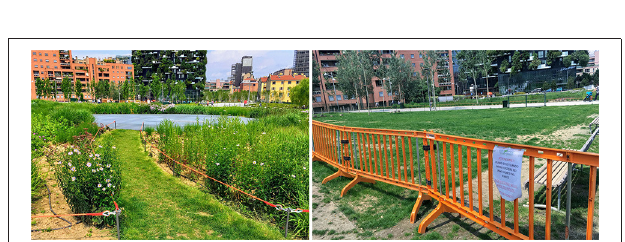
FIGURE 5 | Non-intrusive enclosure of areas that are restricted from use. Temporary closures are installed to help the vegetation to